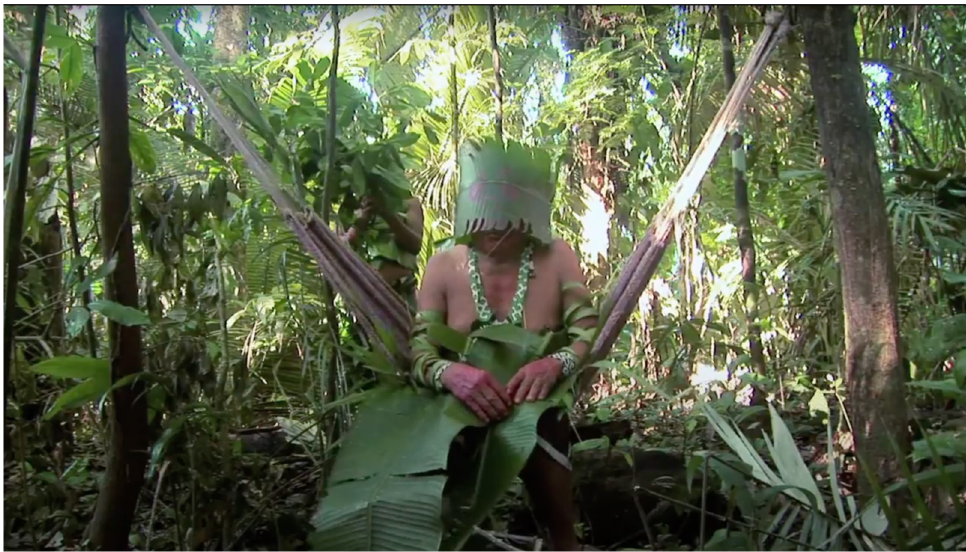
Figure 1. Still from Shuku Shukuwe